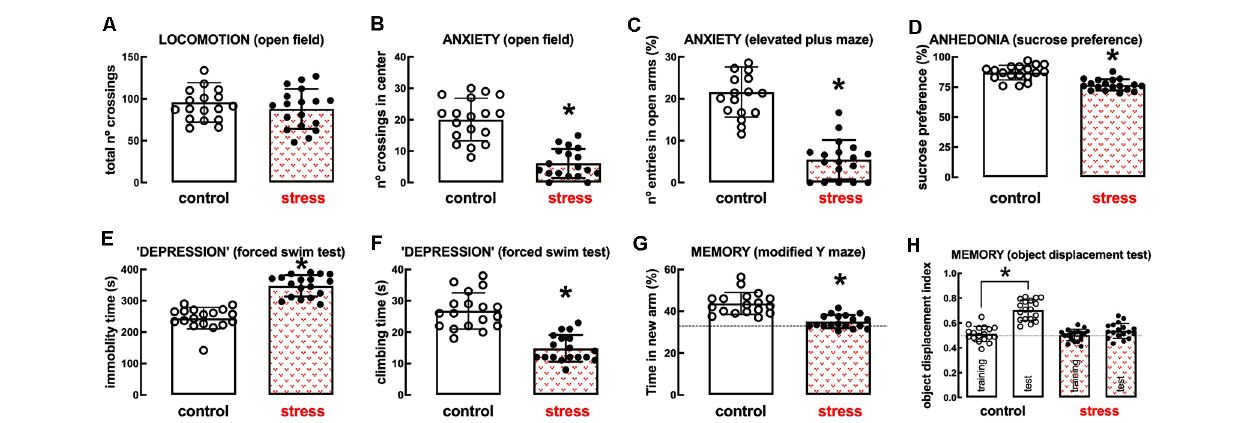
FIGURE 2 | Male adult Wistar rats (8–10 weeks old) subject to a protocol of restraint stress (4 h/day) during 14 days display the expected features of depressed rats. Compared with non-stressed control rats (open bars), stressed rats (red checkered bars) displayed a preserved locomotor activity as evaluated in the open field (A) , anxiety-like behavior as evaluated in the open field (B) , and in the elevated plus-maze (C) tests, anhedonia as evaluated in the sucrose preference test (D) , helpless-like behavior as evaluated by the forced-swimming test (E,F) and impaired memory performance as evaluated by a modified Y maze test (G) and an object-displacement test (H) . Data are shown as mean ± SEM; n = 16–18 rats per group. * P < 0.001 using a Student’s t -test.